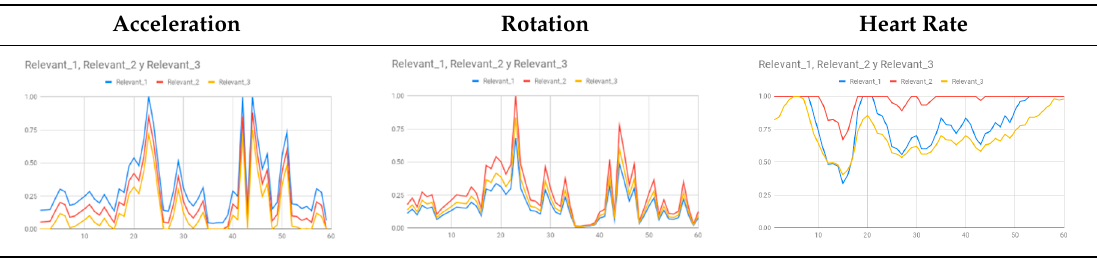
Table 9. Results of the three relevant linguistic terms for each type of data.